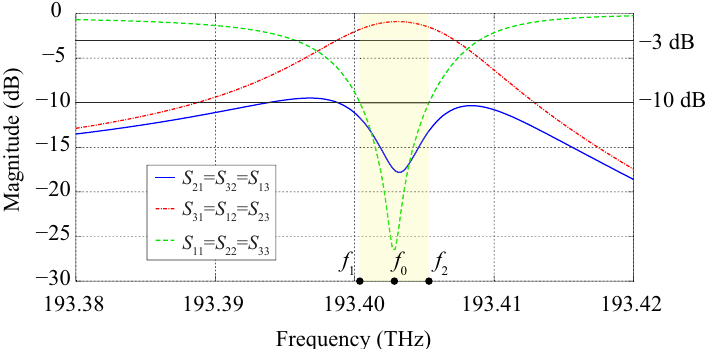
Figure 6. Frequency response obtained from 2D simulations performed with COMSOL